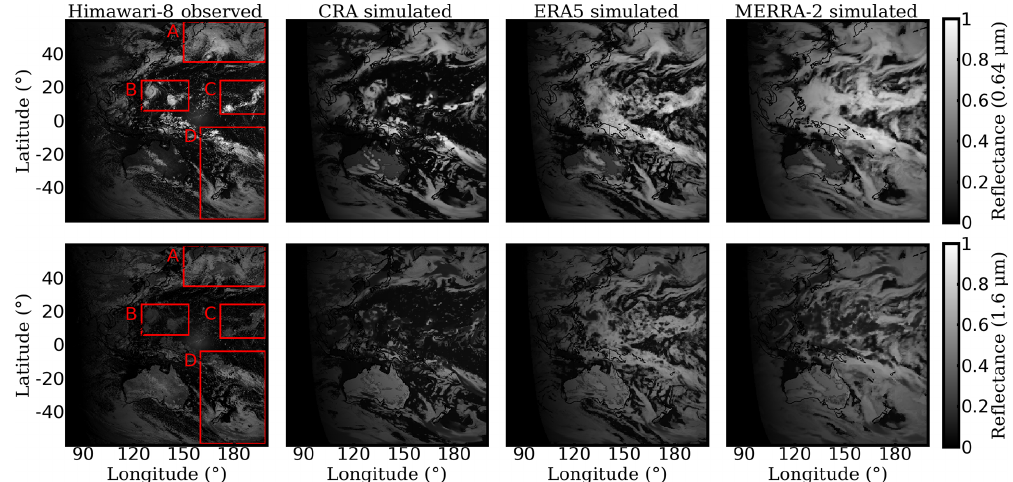
Figure 1. Observed and simulated reflectance in the 0.64µm (top) and 1.6µm (bottom) channels. The results are taken at 00:00 (UTC) on 12 September 2016.